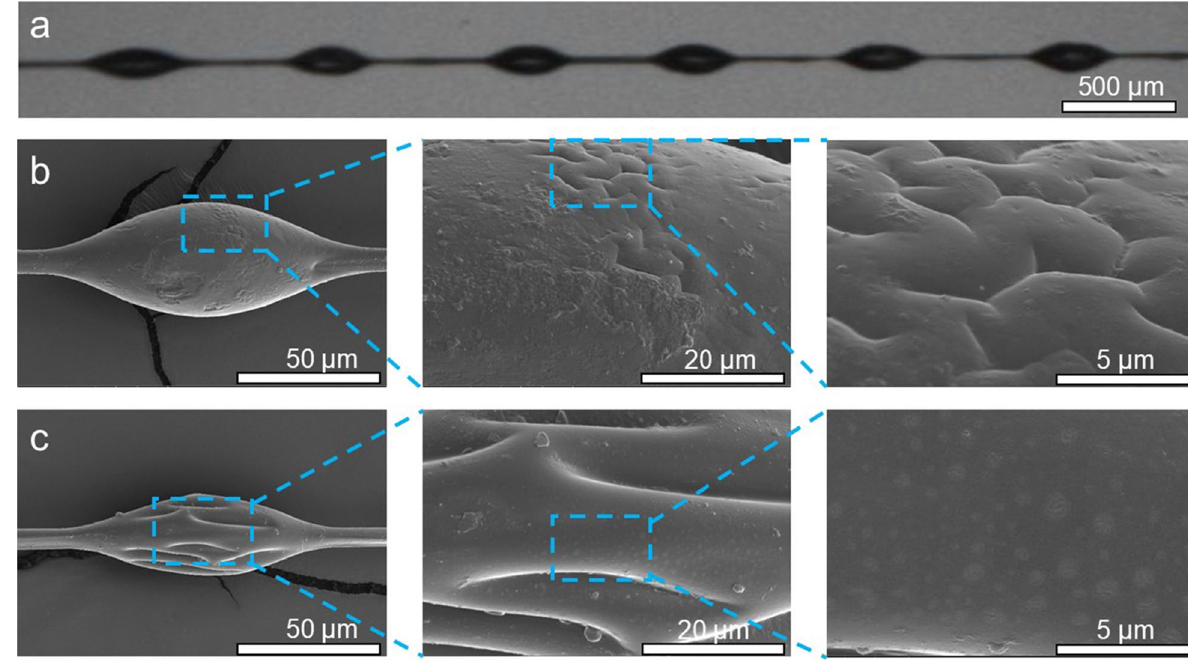
Fig. 2 The morphology of the fabricated fiber. a Optical image of GSF10. b and c Two types of SEM images of GSF10